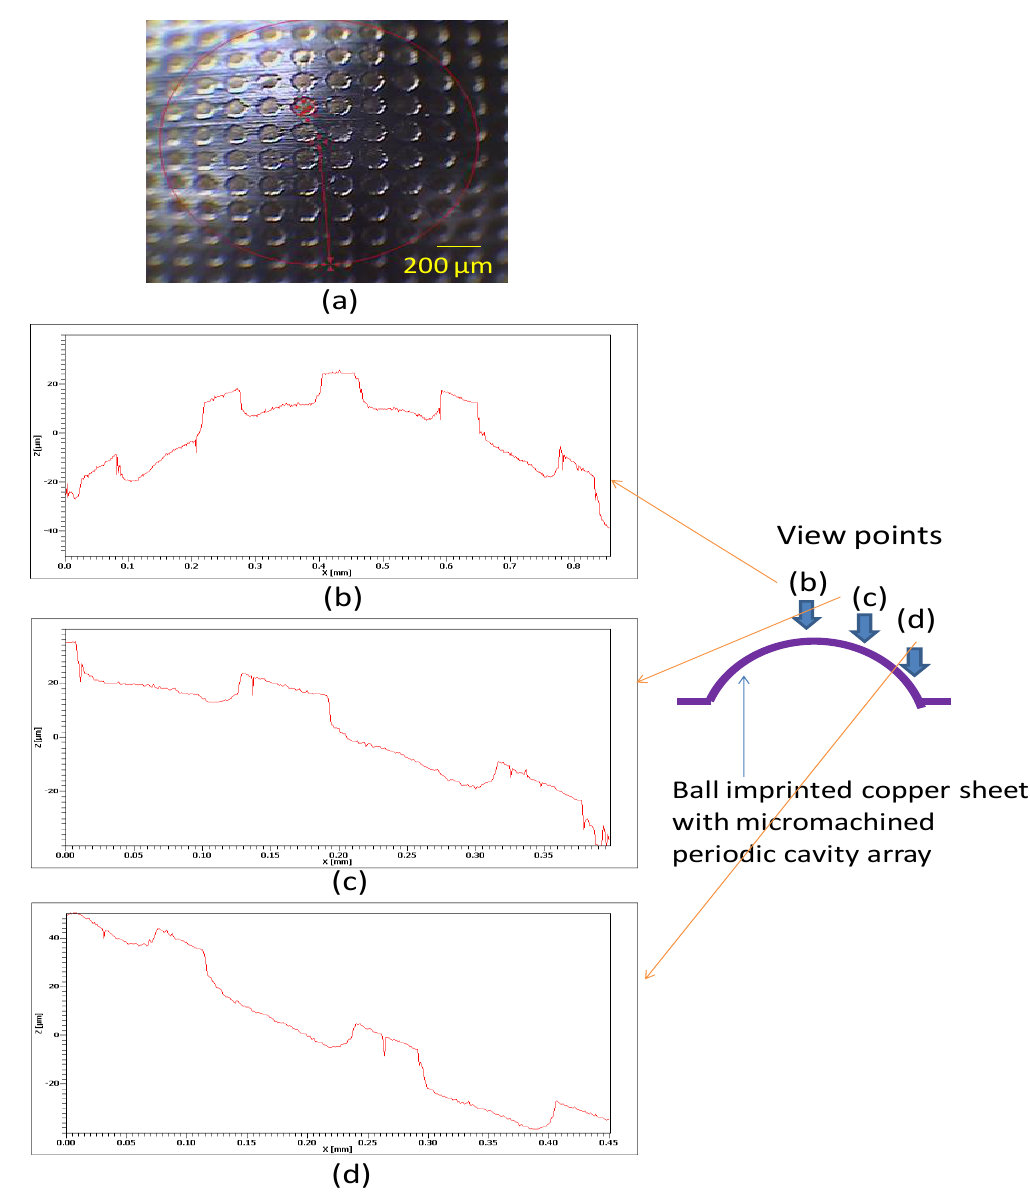
Figure 6. ( a ) Microscopic image of the ball-imprinted copper sheet with periodic micromachined cavities; the image shows the highest region of the sheet; ( b – d ) Profiles of the shaped copper sheet at the vertex region, the middle zone, and the bottom area, taken from the white light